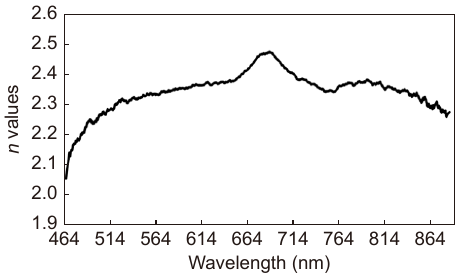
Fig. 5 | Refractive index as a function of wavelength.